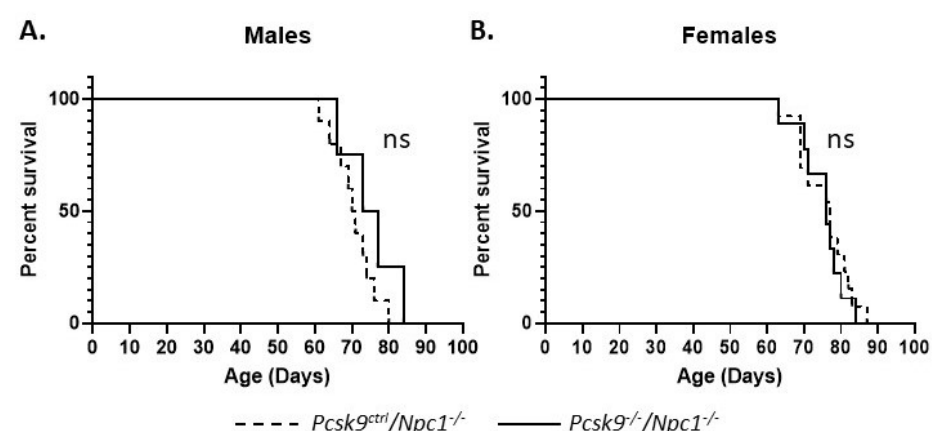
Figure 3. Mouse survival rates in Pcsk9 - / - mice in the context of NPC1 disease. Male and female mutant mice were assessed for survival. The end of life timepoint was assessed based on severity of motor impairment. No significant di ff erence in survival was observed between male ( A ) or female ( B ) Pcsk9 ctrl / Npc1 - / - and Pcsk9 - / - / Npc1 - / - mice.